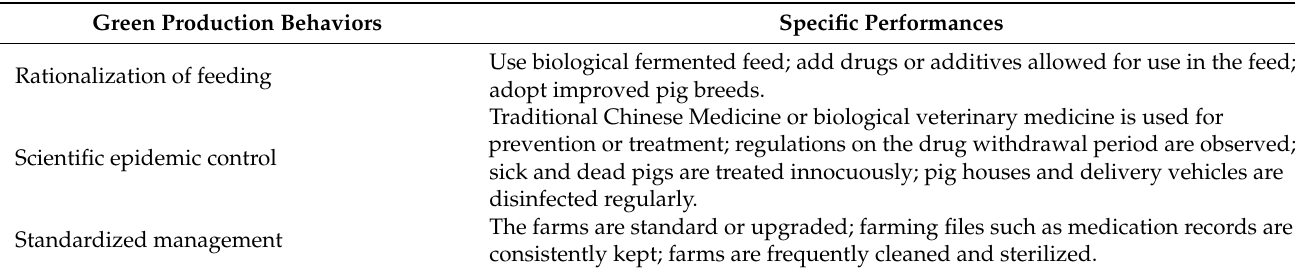
Table 1. Green Production Behaviors of Pig Farmers and Specific Performances. Green Production